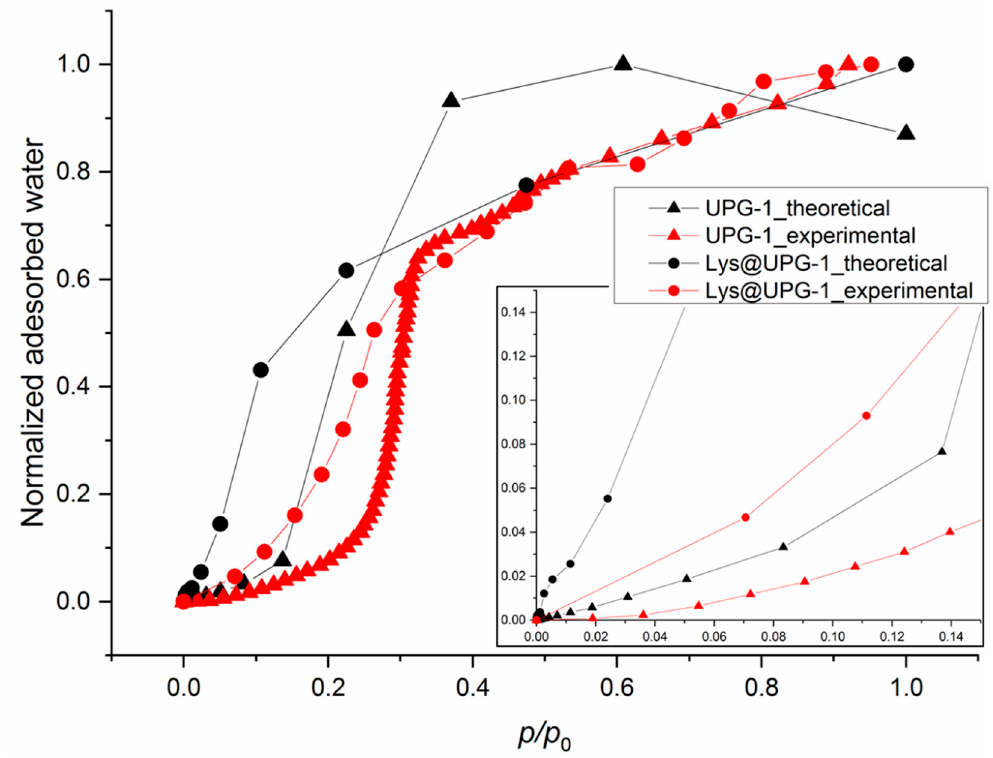
Figure 4. Normalized water adsorption isotherms of UPG-1 and Lys@UPG-1 obtained by molecular simulations (at 25 °C) and experimentally (at 20 °C).